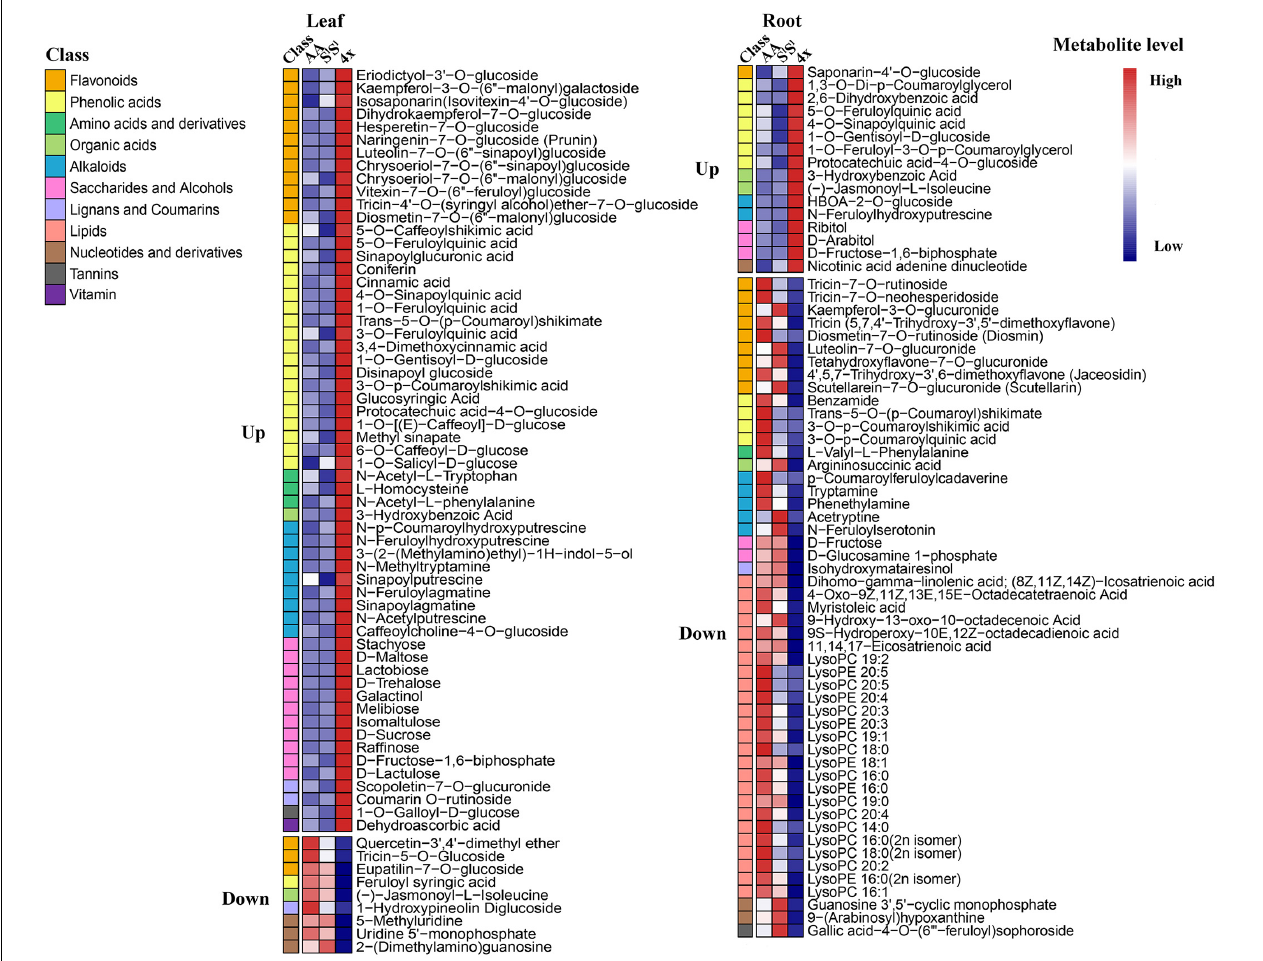
FIGURE 6 | Heatmap showing metabolites with transgressive accumulation in a synthetic tetraploid under control condition. Transgressive up accumulation was defined as 4x/AA > 2 VIP > 1 and 4x/S l S l > 2 VIP > 1, and transgressive down accumulation as 4x/AA < 0.5 VIP > 1 and 4x/S l S l < 0.5 VIP > 1. The seedlings were exposed to 150 mM NaCl for 7 days. The first column showed class name of each metabolite, and the following three columns showed the relative levels of each metabolite for three wheat